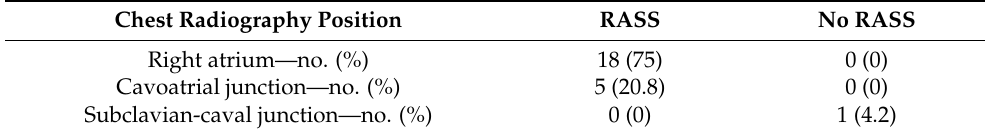
Table 3. Position of retrograde-tunneled HDCs, assessed by portable anterior-posterior chest radiography, with regard to RASS (within one second) or no RASS. Chest Radiography Position RASS Right atrium—no. (%)